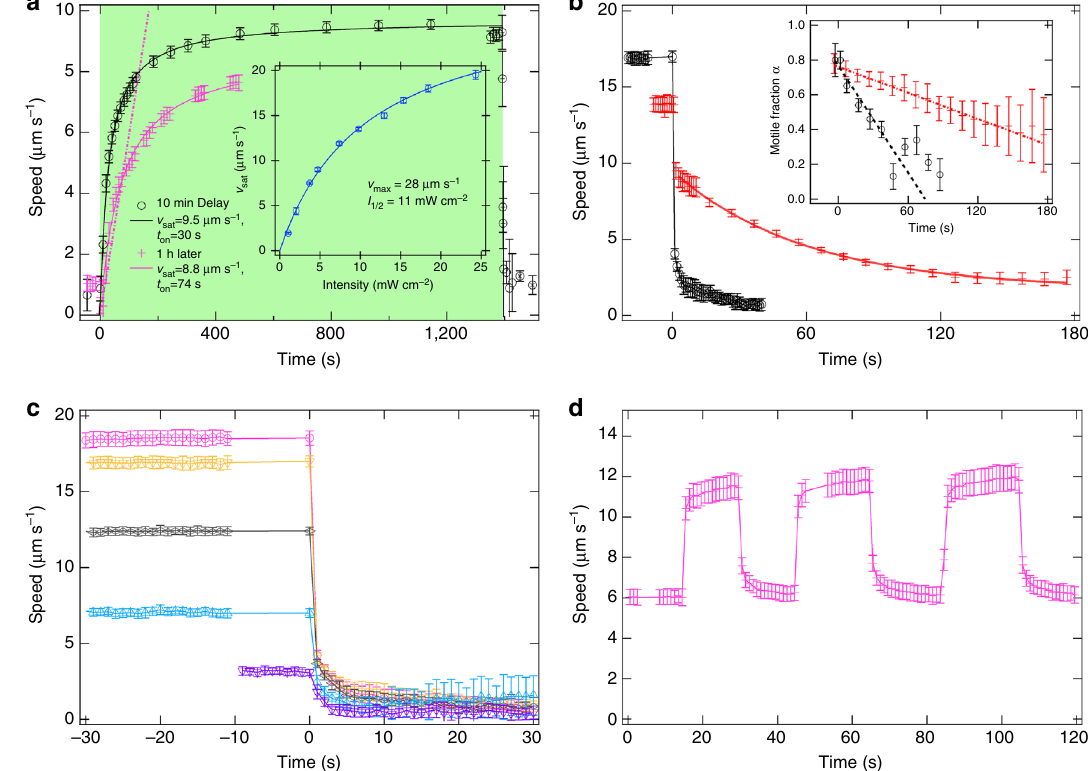
Fig. 1 Response to light. a Population-averaged speed vs. time for initially stationary E. coli AD10, light on at t = 0 and off at t ≈ 1,400 s (black circles); green shading = illuminated, and the data point just after switch-off are 1 s apart. This sample was measured soon after the cells had run out of O 2 . One hour later, cells accelerated less rapidly (magenta crosses). Full lines: fi ts to v ð t Þ ¼ v sat t = t þ τ on ð Þ . The dot-dashed line shows the acceleration (0.05 μ m s − 2 ) obtained from ‘ box emptying ’ experiments starting from stationary cells. Inset: dependence of v sat on incident light intensity (points) fi tted to v sat ðIÞ ¼ (cid:1) (cid:3) v = I þ I (see Supplementary Note 1). b Strain AD10 with unc -cluster deletion shows a rapid decrease in v when illumination ceases (black 1 = 2 max I circles). In a strain without unc -cluster deletion (AD57), a signi fi cant fraction of the population (see inset for the motile fraction α = 1 − β , where lines are guides to the eye) continues to swim at reduced speed, resulting in a much slower decay of v (red crosses; solid red line: offset exponential fi t, giving τ ≈ 60 s). c Average swimming speed of AD10 as green light is switched off (at t = 0): τ off ≈ 1 s independent of the initial swimming speed (at the resolution limit of our technique). d AD10 bacteria adapt their swimming speed within 1 s as the green light is alternated between low and high intensity. In this case τ ≈ τ q = 0.5 – 1.5 μ m − on off . Error bars in all these plots depict SD from the mean speed over a range of t ≲ τ on . The time to empty an L × L square should thus scale as